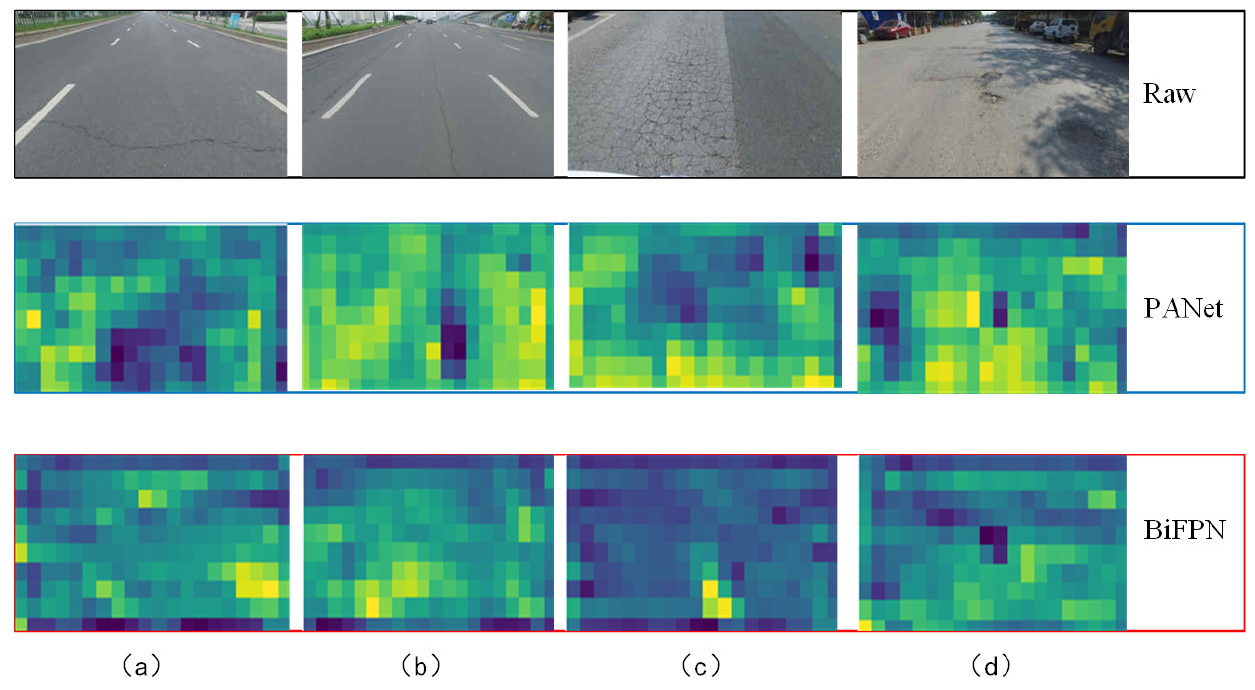
Figure 3. Comparison of BiFPN and PANet network structures [35,51]. ( a ) is the PANet network structure, and ( b ) is the BiFPN network structure, where conv is convolution node.